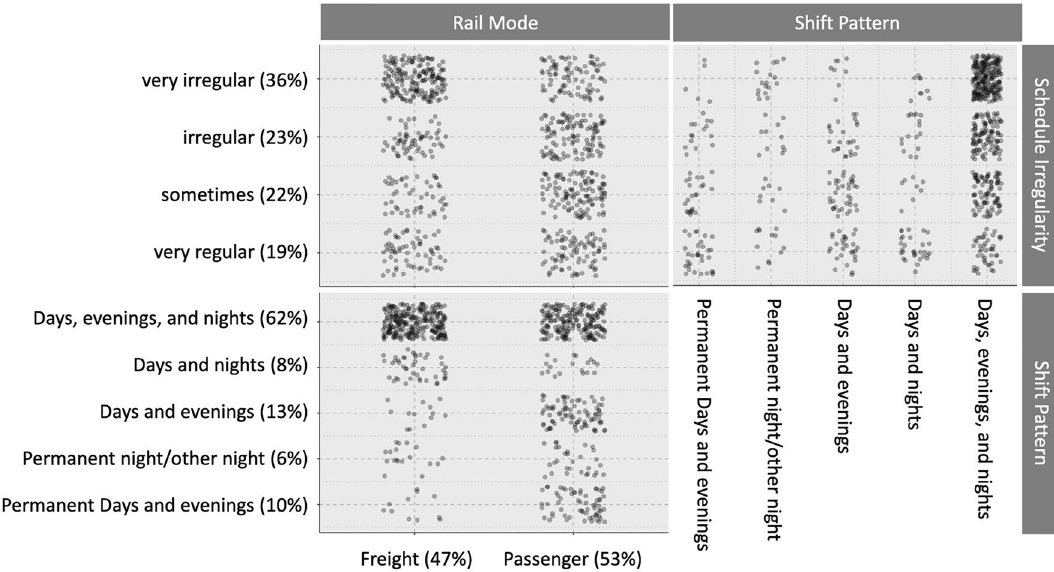
Figure 1. Jitter matrix showing proportion drivers in each Rail Mode across Shift Pattern and levels of Schedule Irregularity.